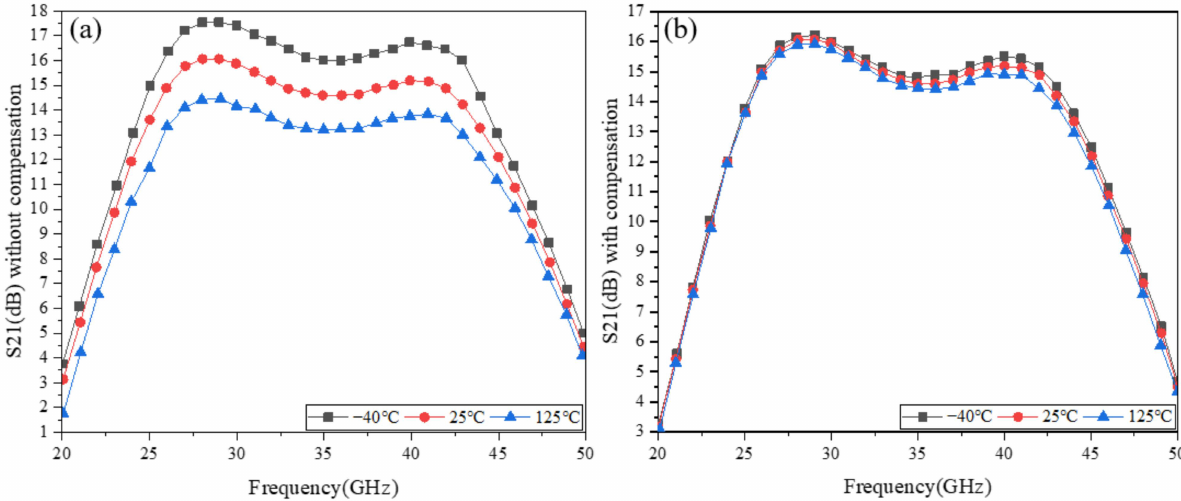
Figure 7. Small-signal gain versus temperature variation: ( a ) without temperature compensation; ( b ) with temperature